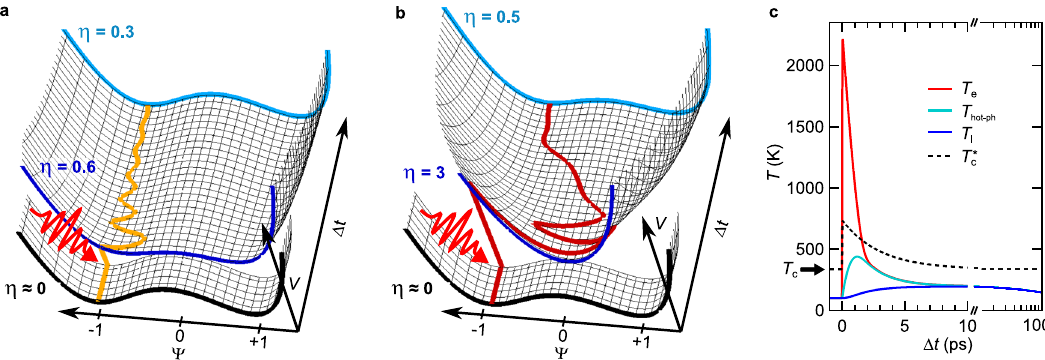
Fig. 4 Simulated order-parameter dynamics and 3TM. Transient potential energy surface and order-parameter pathway upon a weak and b strong optical excitation. The potential shapes before excitation (black curve), at 0 ps (dark blue) and 3.5 ps (light blue) are highlighted. a In the AM regime, the double- well potential is weakly modi fi ed, while in b the overshoot regime, the CDW melting threshold is reached, resulting in a single-well shaped potential, followed by a relaxation to the double-well ground state. c 3TM of electronic, hot phonon and lattice temperatures T e , T hot − ph and T l in the regime of strong perturbation ( F = 0.35 mJ cm − 2 ). In the 3TM, the optical excitation of the electronic system is followed by an energy transfer to certain strongly coupled optical phonons, widely observed in materials with selective electron-phonon coupling 27,51,52,61 – 63 . Subsequently, this hot phonon subset equilibrates with the remaining lattice phonon bath on a ps timescale ( τ ph − ph ). To account for the recovery of the base temperature via heat diffusion on a 100 ps timescale, the lattice is coupled to an external heat sink. The black dashed line indicates the rescaled critical temperature T (cid:3) . In the 3TM simulations, material c properties of the related compound LaTe 3 27 were